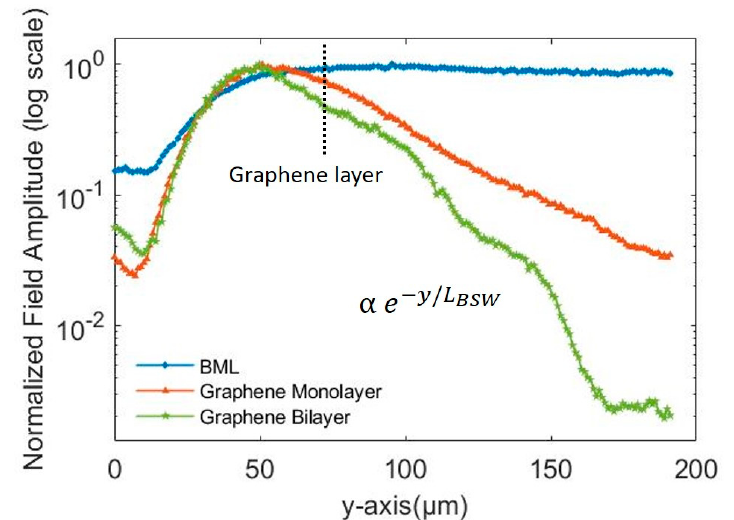
Figure 5. The normalized field amplitude cross section (in logarithmic scale) along the direction of propagation of BML, monolayer and bilayer of graphene.